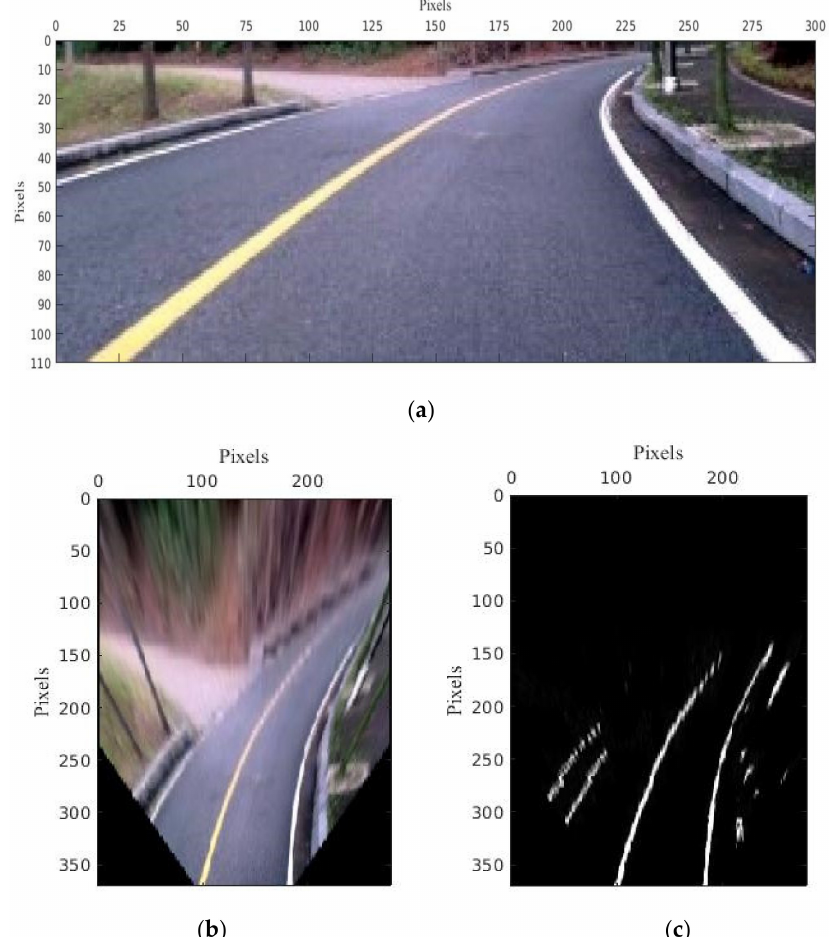
Figure 20. Top view transformed image; ( a ) Real image for top view transformation, ( b ) Top